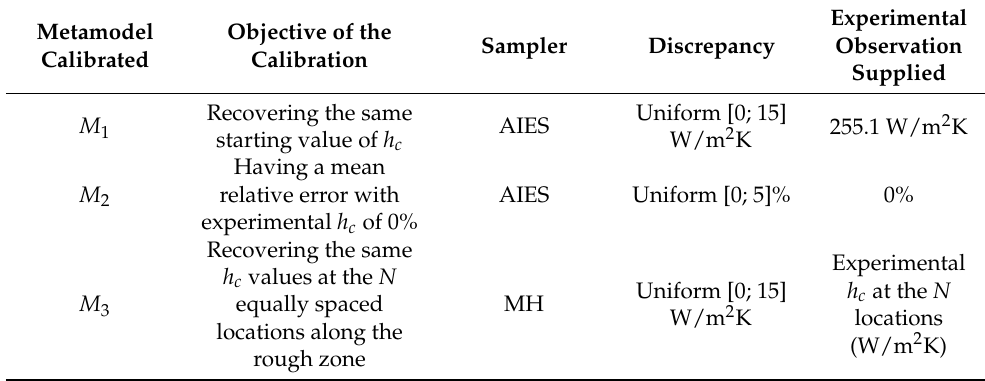
Table 3. Bayesian solver settings.